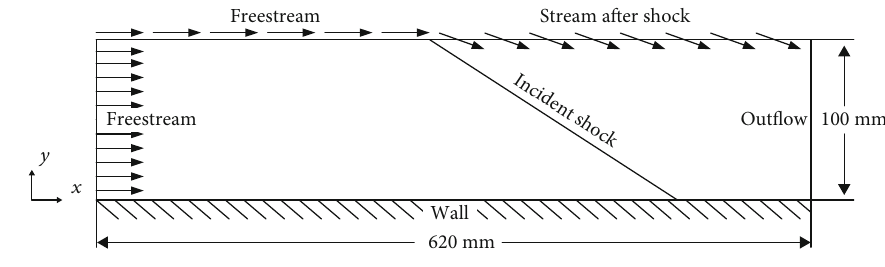
Figure 2: Computational domain and the boundary conditions.